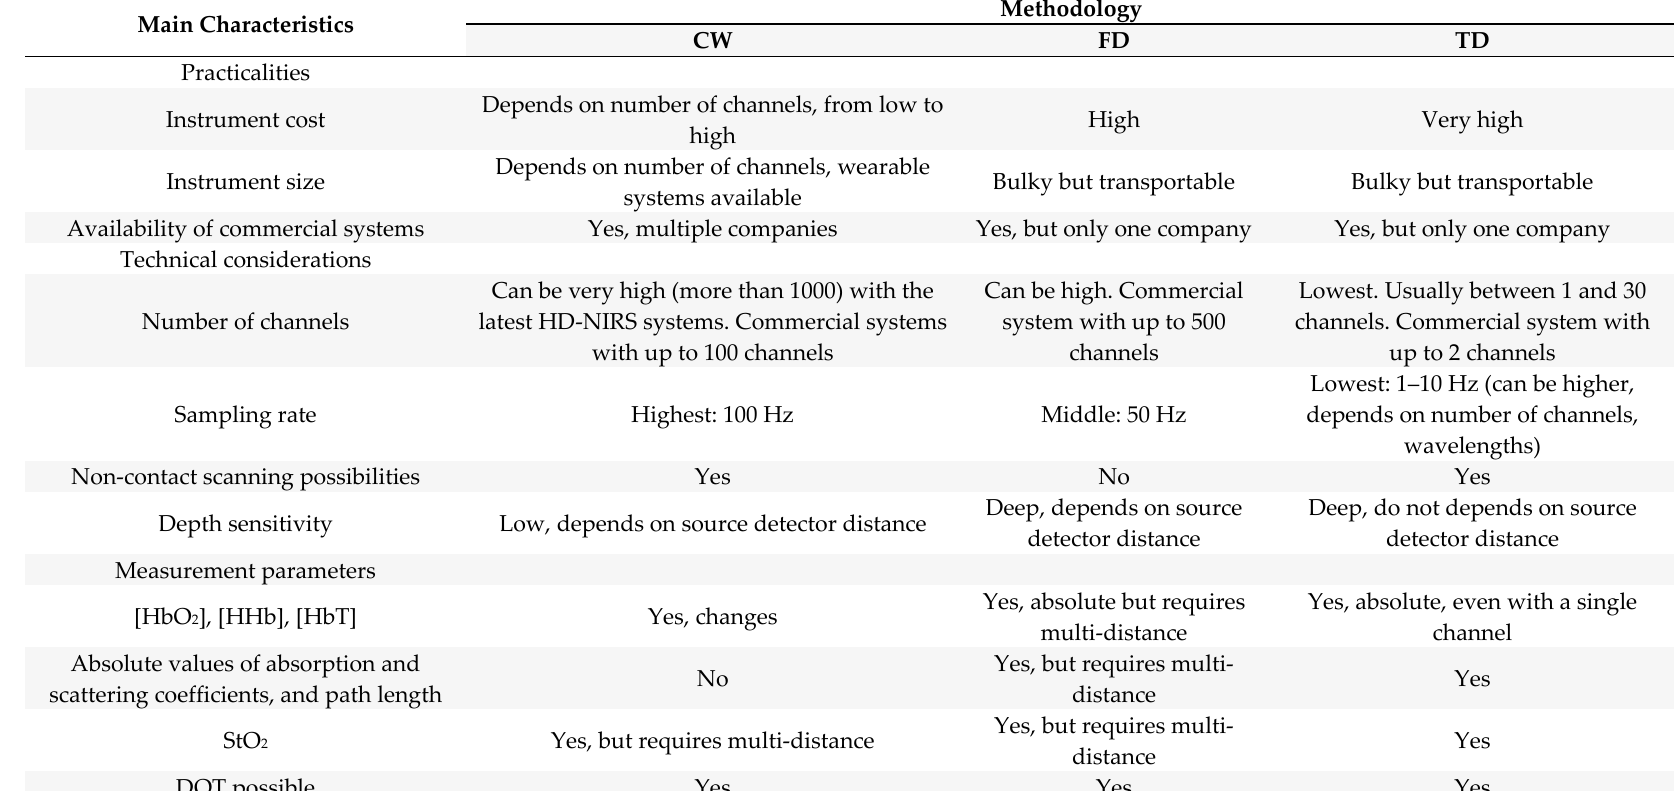
Table 1. Characteristic of the three NIRS methodologies.